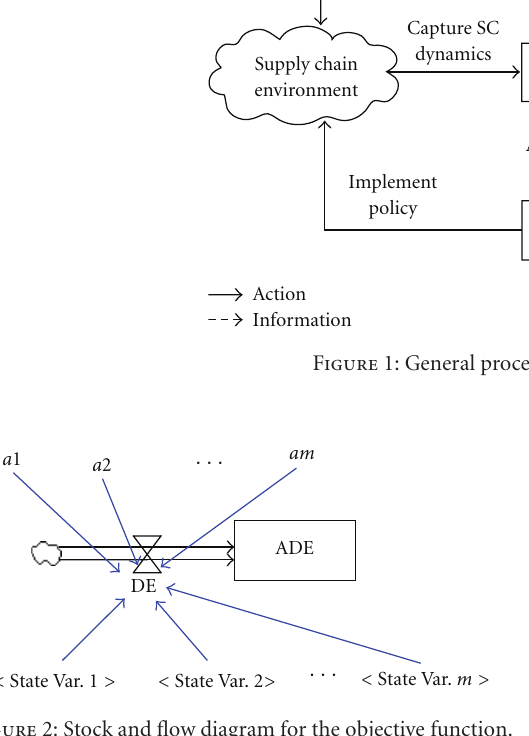
The objective function J ( p ) is defined as the weighted average value of the ADE, and T is the time horizon. The use of weights, w s , means that J ( p ) will support the simultaneous stabilization of any subset of m state variables ( m ≤ n ). This allows higher weights to be assigned to the variables that are considered more